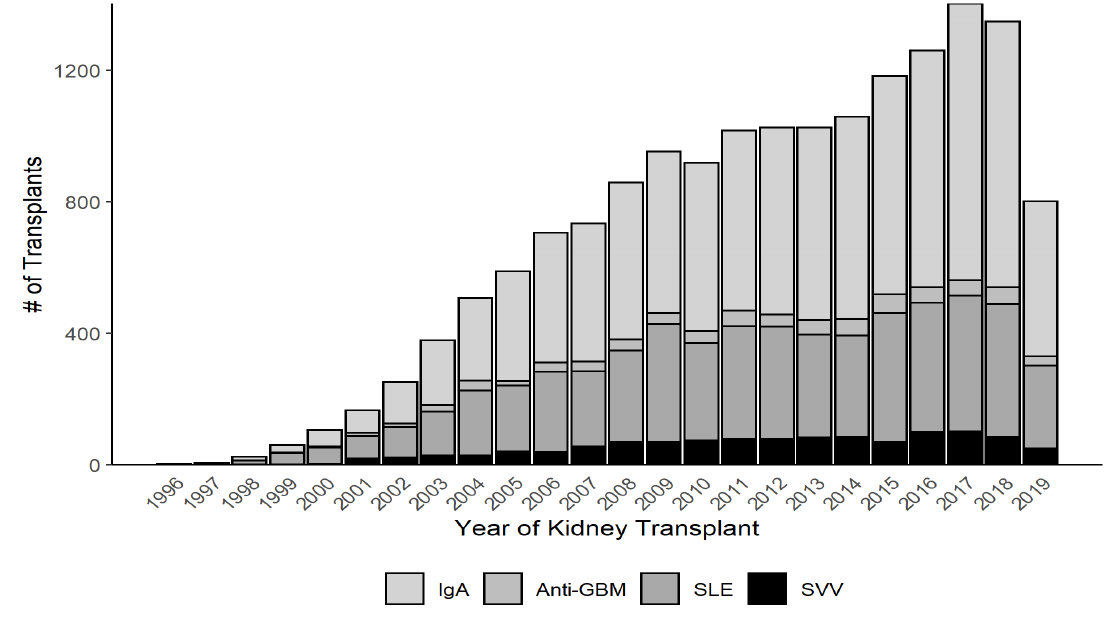
Figure 1. Transplant Number by Glomerulonephritis Type. Table 1. Baseline Characteristics by Glomerulonephritis Type (N (%) or Mean